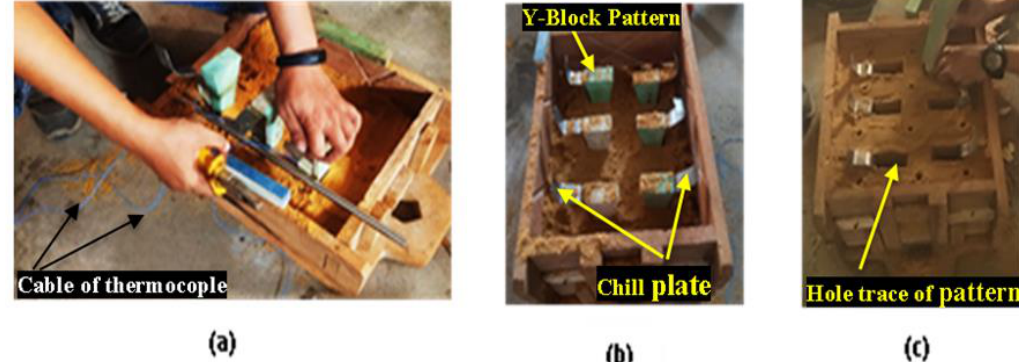
Figure 2: Model of molding and specimen adjustment procedure. a) thermocouple cable installation touched to the chill plate; b) the sample arranged in the mold; c) plate chill condition on the surface of a tracing